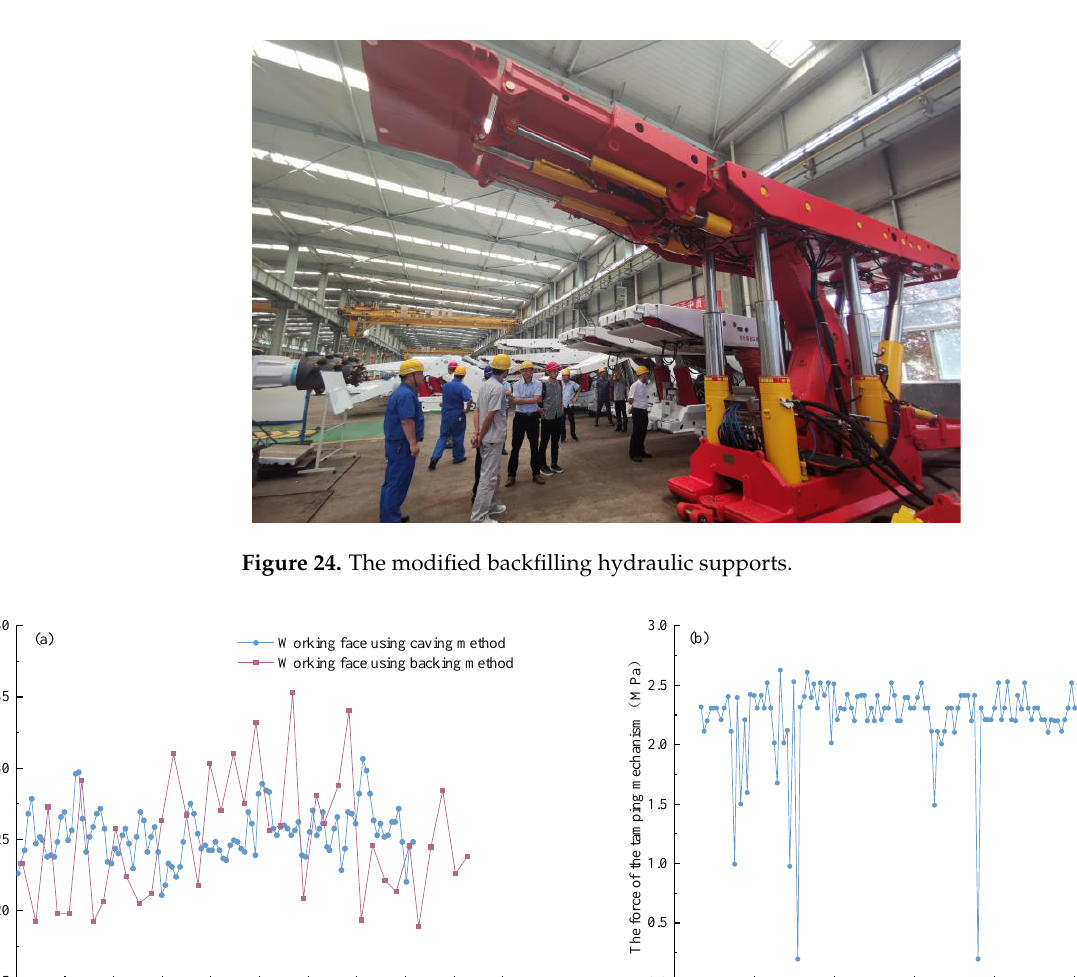
Figure 24. The modified backfilling hydraulic supports.